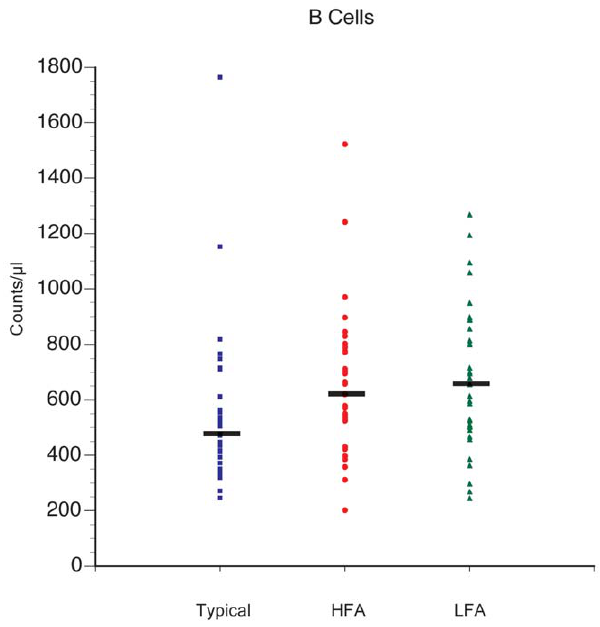
Figure 1. Average B cell counts are higher in the HFA and LFA groups compared with controls. The absolute count values are based on 9 separate B cell assays that use CD20 as the B cell identifier. P-values=* HFA vs. N=0.011, ** LFA vs. N=0.009, and A vs. N 0.003. HFA vs. LFA=not significant (0.7). doi:10.1371/journal.pone.0019299.g001 PLoS ONE |